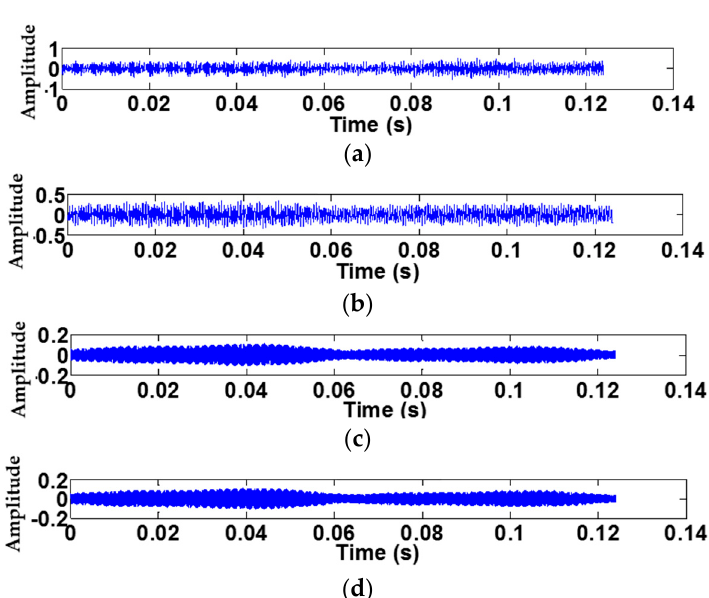
Figure 10. Time ‐ domain waveform of the de ‐ noised serious outer race fault in bearing 1: ( a ) De ‐ noised signal by MMBDSOICE; ( b ) De ‐ noised signal by MMBCSOICE; ( c ) De ‐ noised signal based on MPODSOISE; ( d ) De ‐ noised signal based on MPOCSOISE.